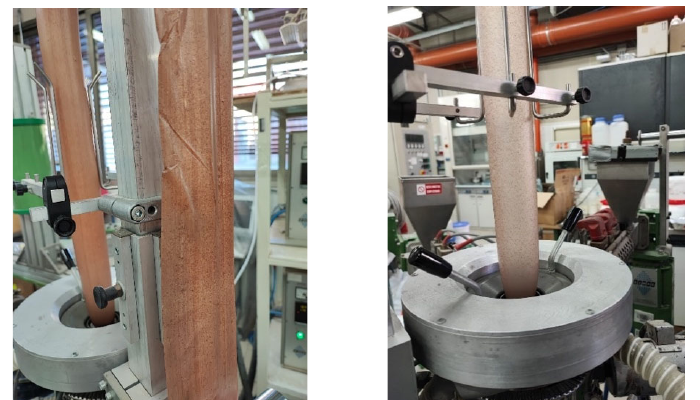
Figure 2. Film blowing of Ecovio/HP 90/10 at different draw ‐ up speeds:1.6 m/min ( left ) and 3 m/min ( right ). Table 2. Nomenclature and average thickness of film samples produced at different draw ‐ up speeds.